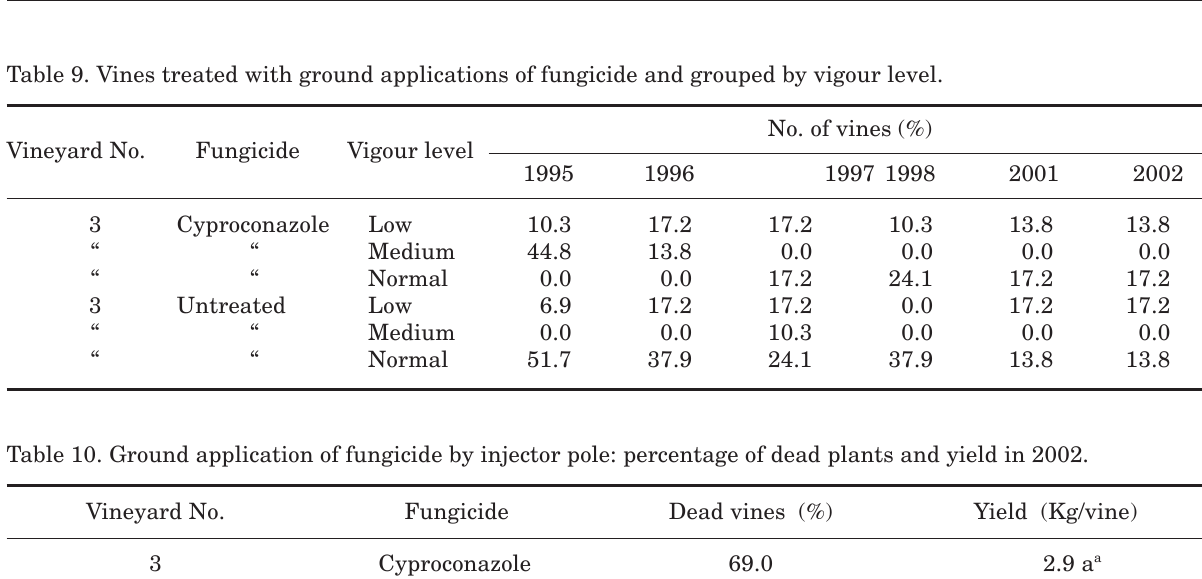
Table 8. Growth resumption of vines with trunk renewal and post-treated with ground applications by injector pole. Vineyard No.